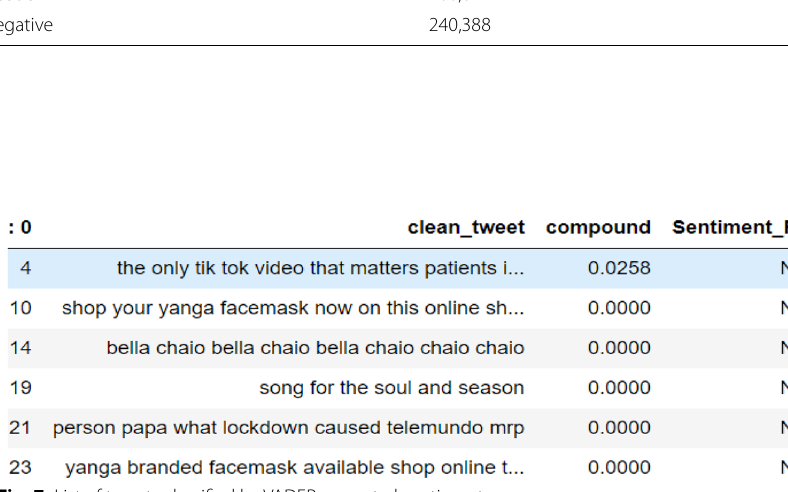
Fig. 7 List of tweets classified by VADER as neutral